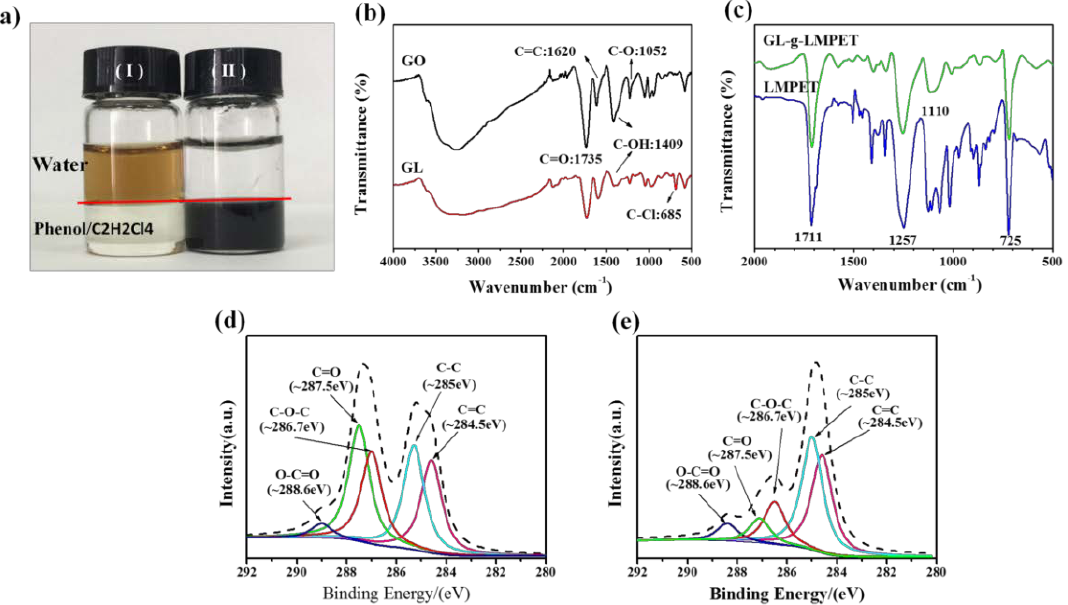
Figure 2. ( a ) solubility of GO (I) and GL- g -LMPET (II) in H 2 O (up)/ Phenol and C 2 H 2 Cl 4 (down) solution; ( b ) FTIR spectra of GO and GL; ( c ) FTIR spectra of GL- g -LMPET and LMPET; XPS spectra (C1s) of GO ( d ) and GL- g -LMPET ( e ).